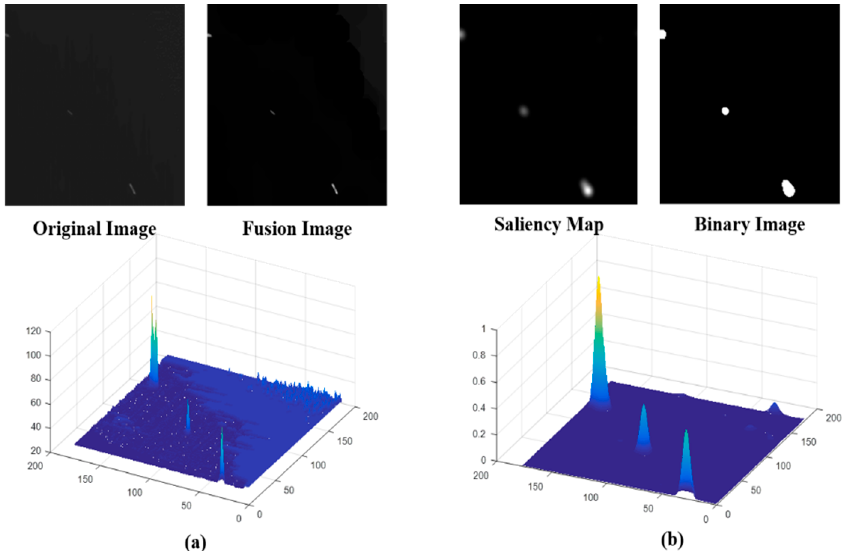
Figure 6. Rapid saliency model (RSM) for simple local scene ship detection. ( a ) is the original image and fusion image analysis and ( b ) is the saliency map and binary image analysis.